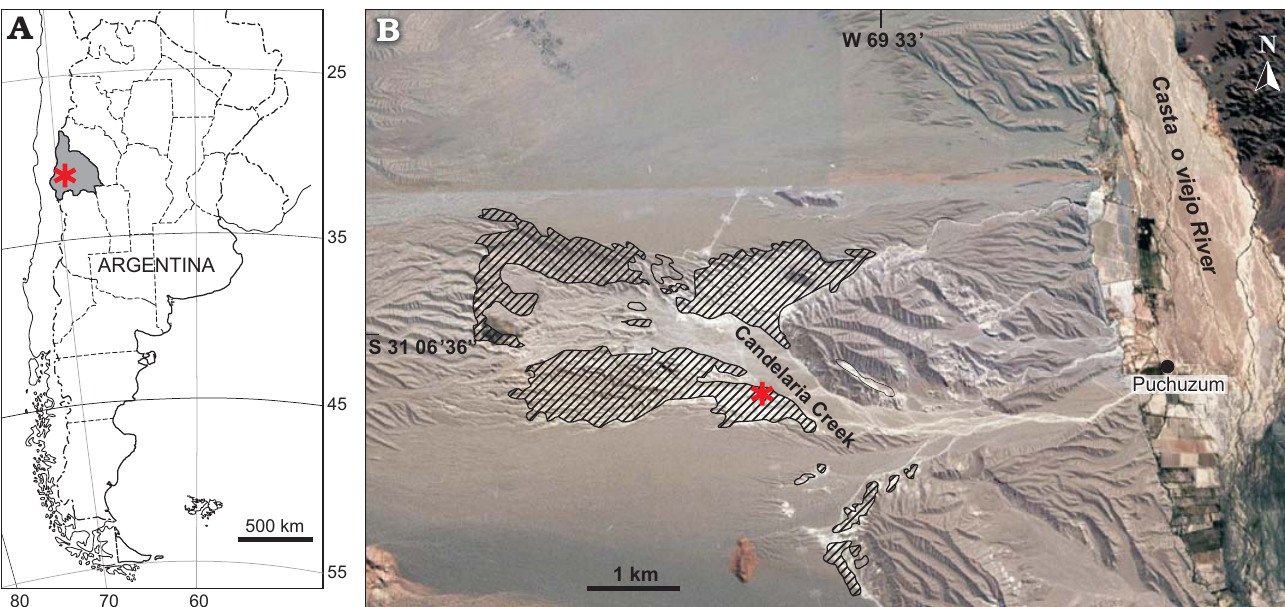
Fig. 1. Geographical map showing position of studied area within San Juan Province, central-west Argentina ( A ) and location of outcrops of the Las Flores Formation (striped area) near the village of Puchuzum ( B ). The asterisks indicate the fossil